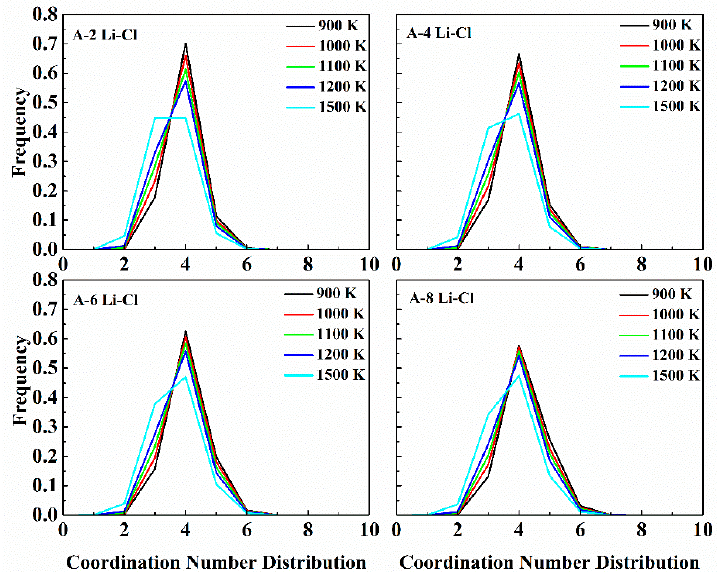
Figure A5. The coordination numbers distribution of four compositions at various temperatures: Li- Cl.